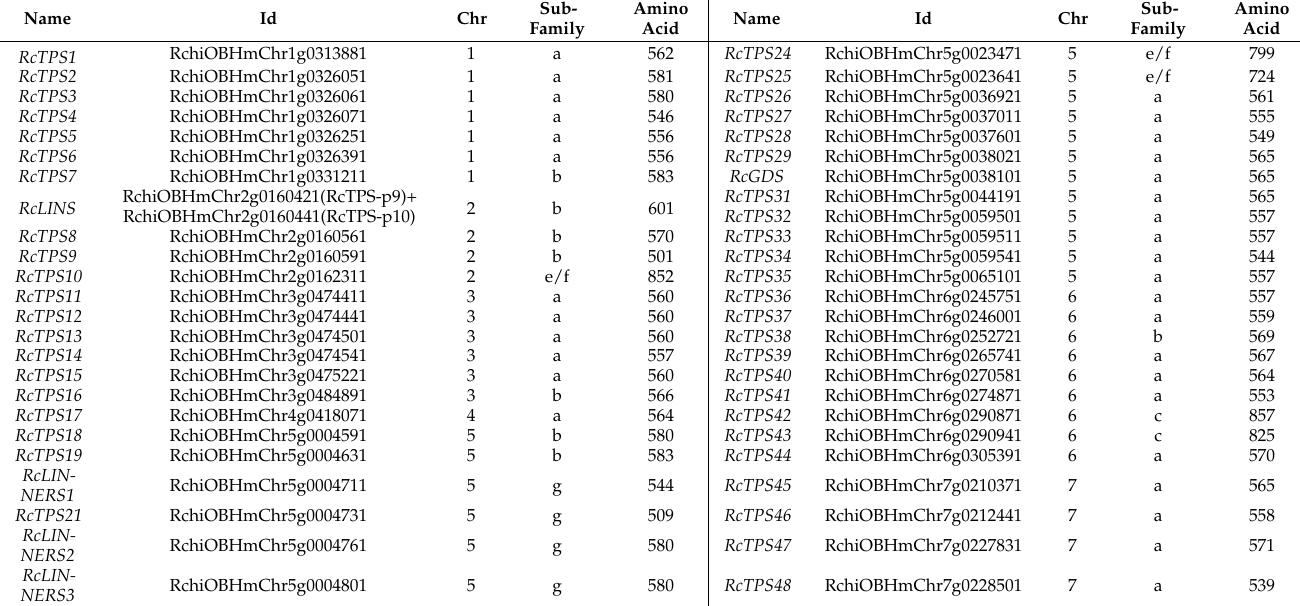
Table 2. Members of 49 complete RcTPS